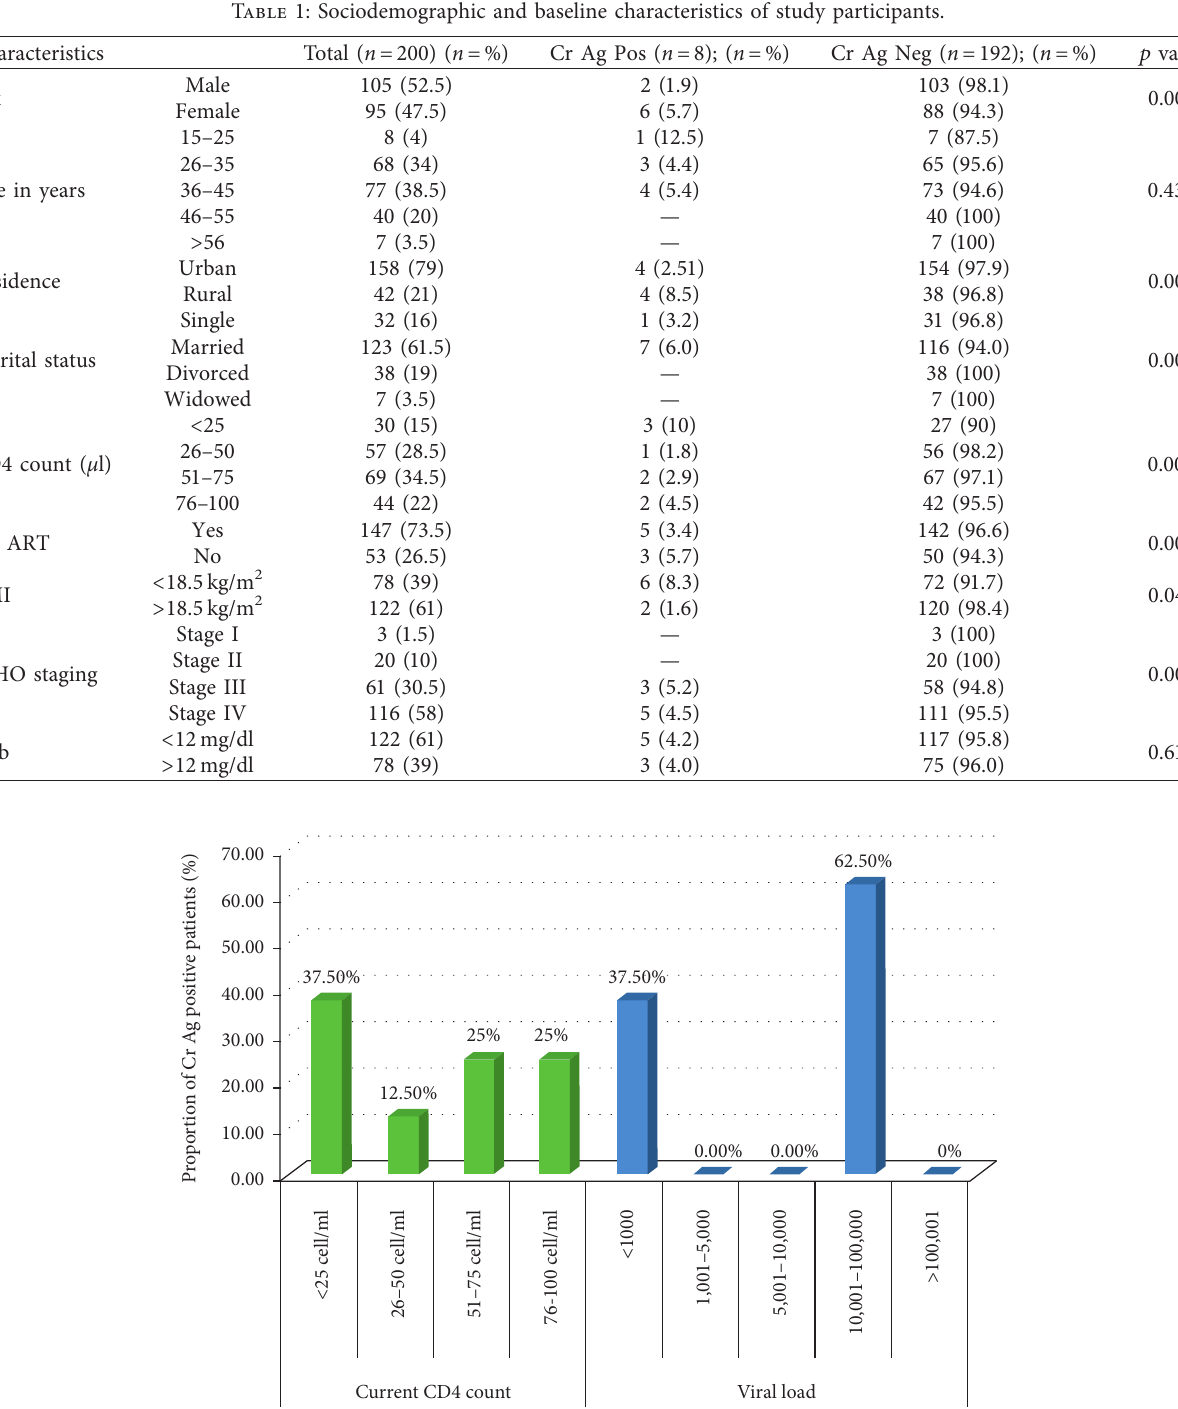
Figure 1: Cryptococcal antigenemia in relation to CD4 cells count and HIV